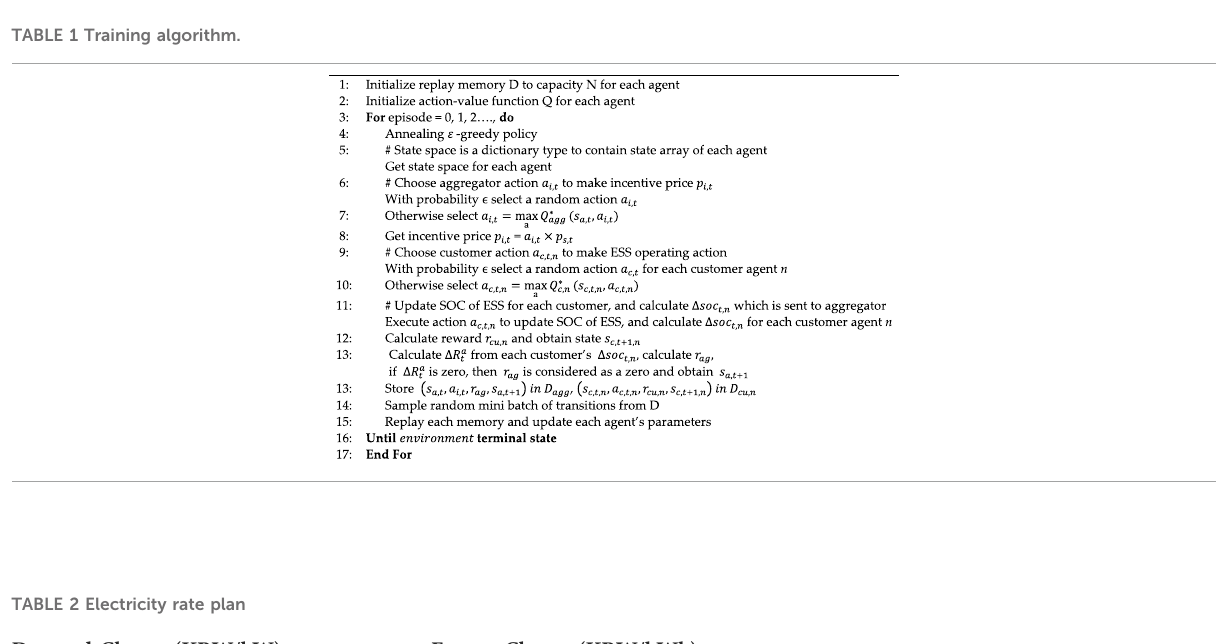
TABLE 1 Training algorithm.